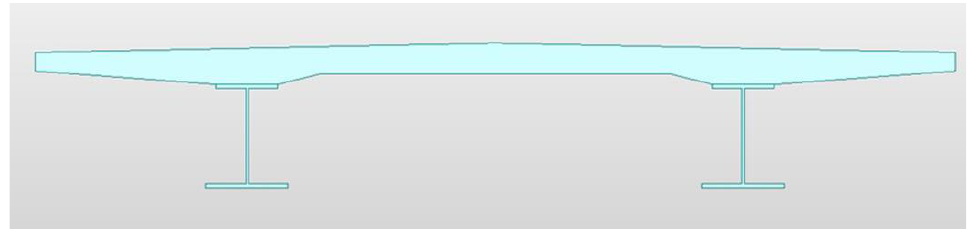
Figure 5. Cross-section of the two-element model.